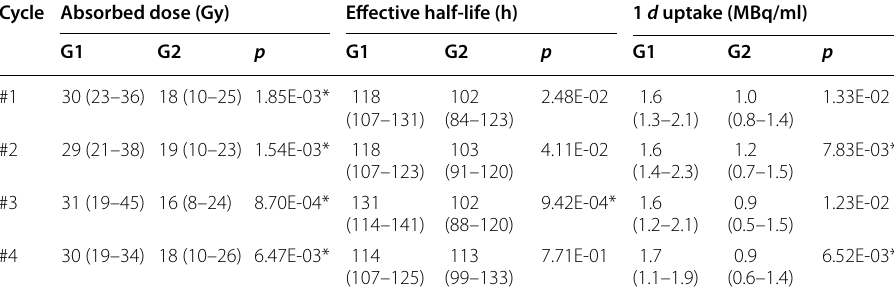
*Significant difference between G1 and G2 ( p < 0.01) in two‑sample Student’s t ‑test